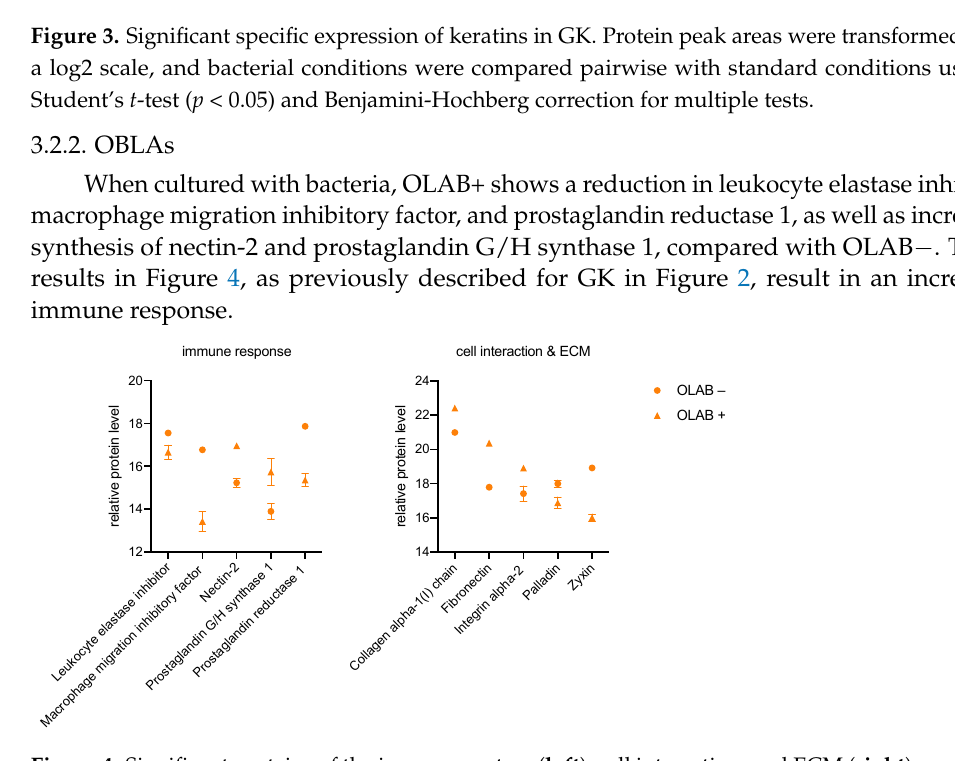
Figure 4. Significant proteins of the immune system ( left ), cell interaction, and ECM ( right ) measured in OLAB. Protein peak areas were transformed with a log2 scale, and bacterial conditions were compared pairwise with standard conditions using a Student’s t -test ( p < 0.05) and Benjamini- Hochberg correction for multiple tests. “+” indicates culture with bacteria; “–” indicates culture without bacteria.